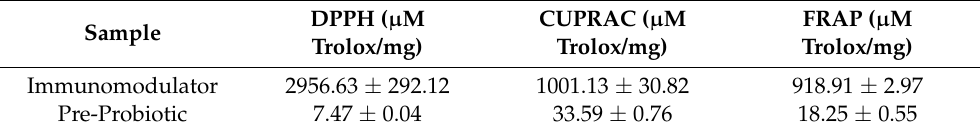
Table 2. Antioxidant activity of the Immunomodulatory and Pre-Probiotic products.